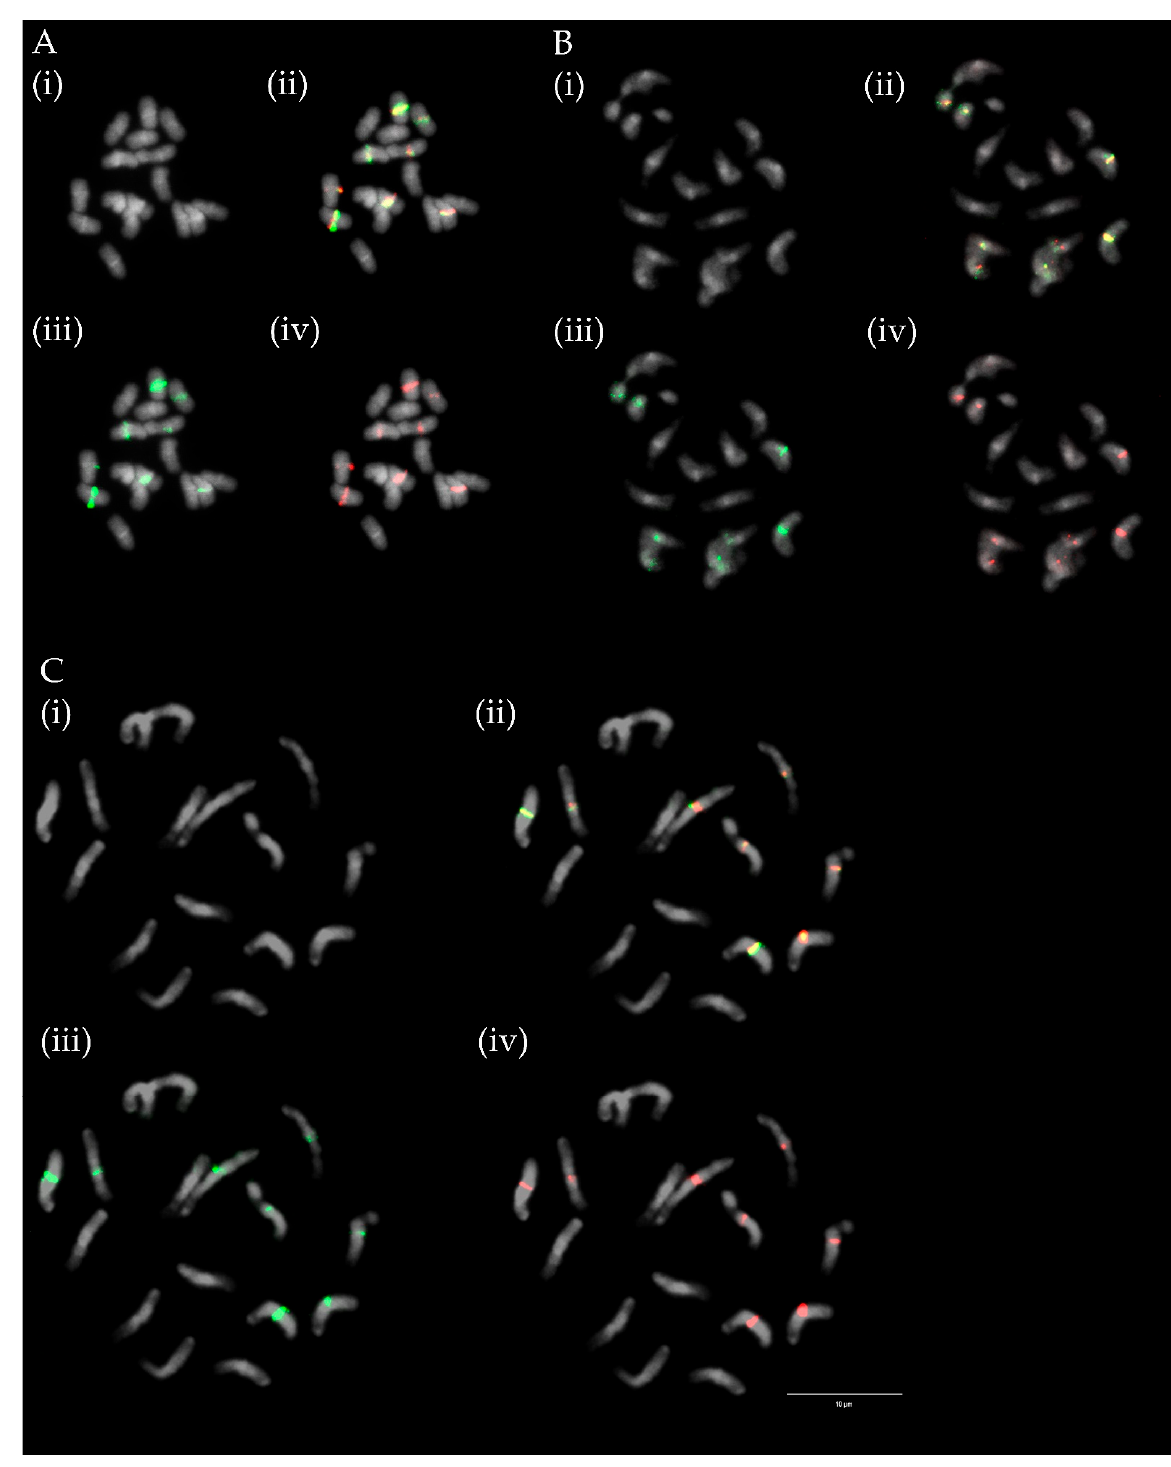
Figure 6. Hybridization patterns of centromeric repeats TrM378 (red) and TrM300 (light green) on metaphase chromosomes of ( A ) T. alpestre , ( B ) T. pignantii , and ( C ) T. rubens . Four pictures are presented for each species; (i) chromosome spread without fluorescent signals, (ii) with merged signals, (iii) with only TrM300 signals and (iv) with only TrM378 signals. Centromeric repeats were observed on half of the chromosomes of all analysed species, with TrM300 prevalent in one and TrM378 prevalent in three chromosome pairs. Scale bar = 10 μ m.